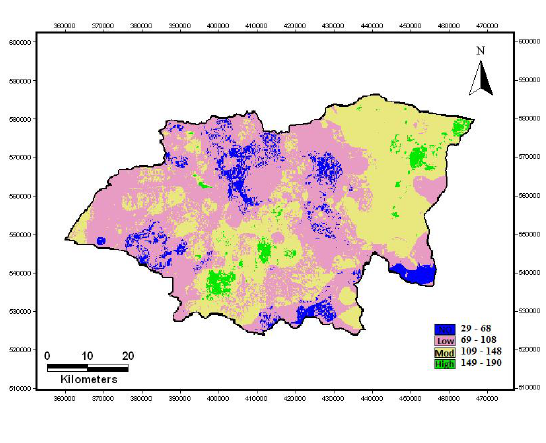
Figure 12. Final Modified DRASTIC risk assessment class’s index